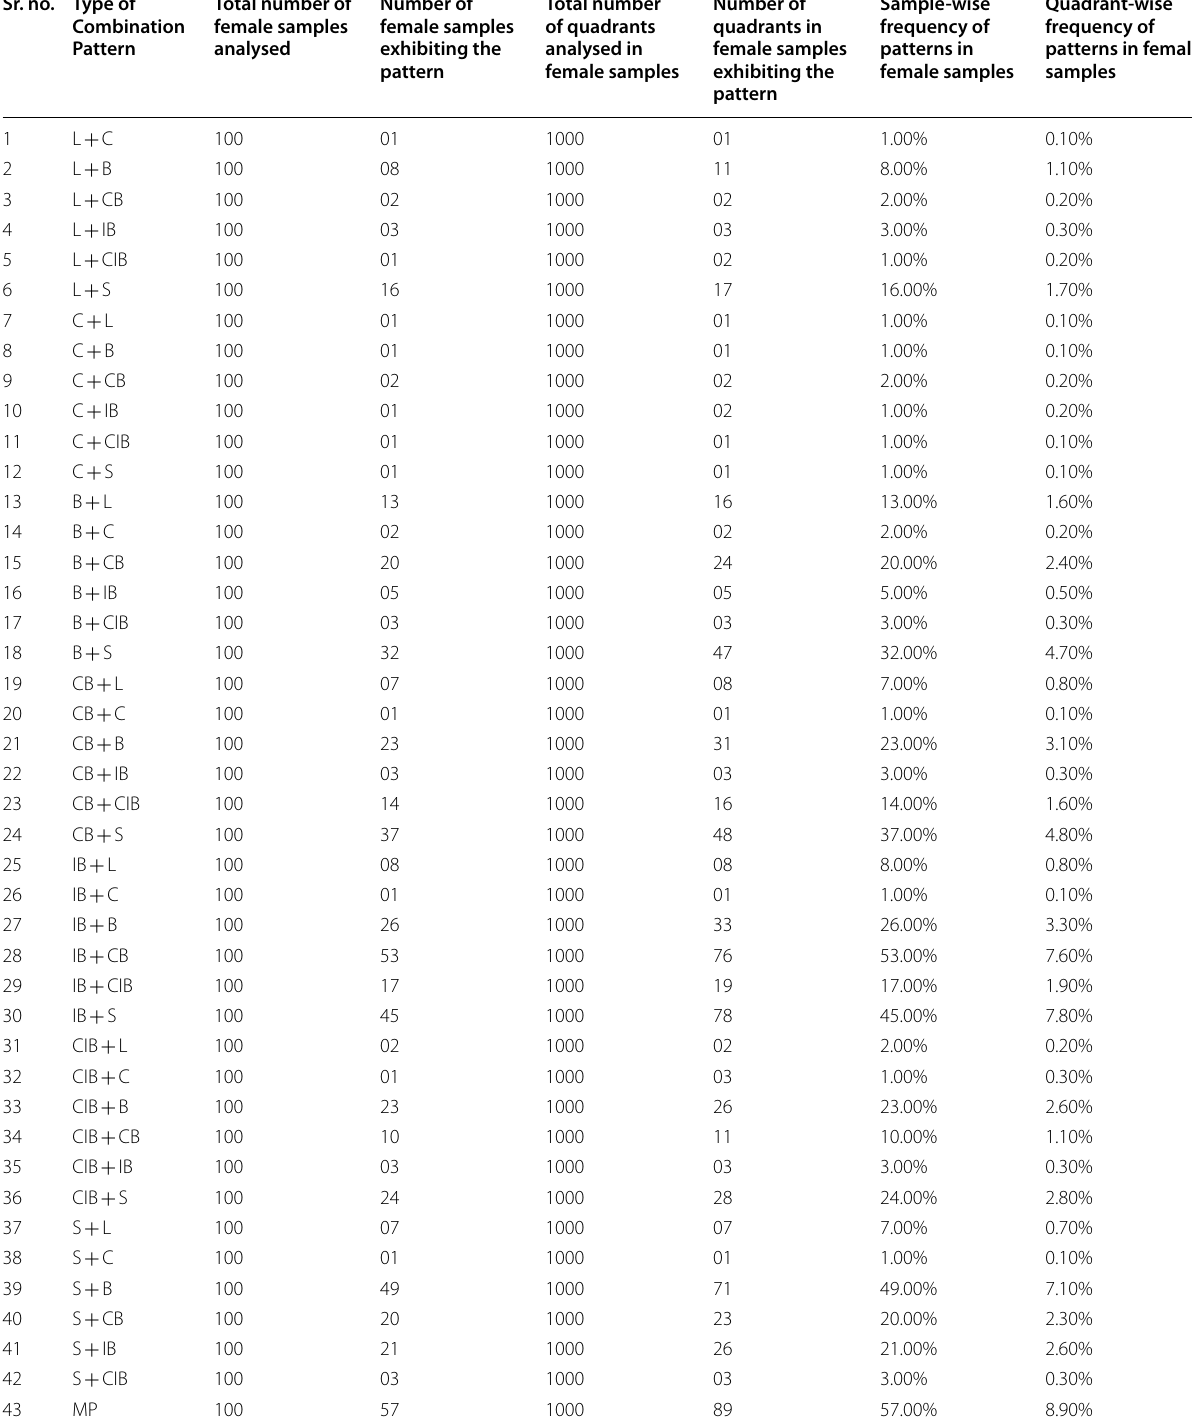
Table 8 Frequency of Combination Patterns in female